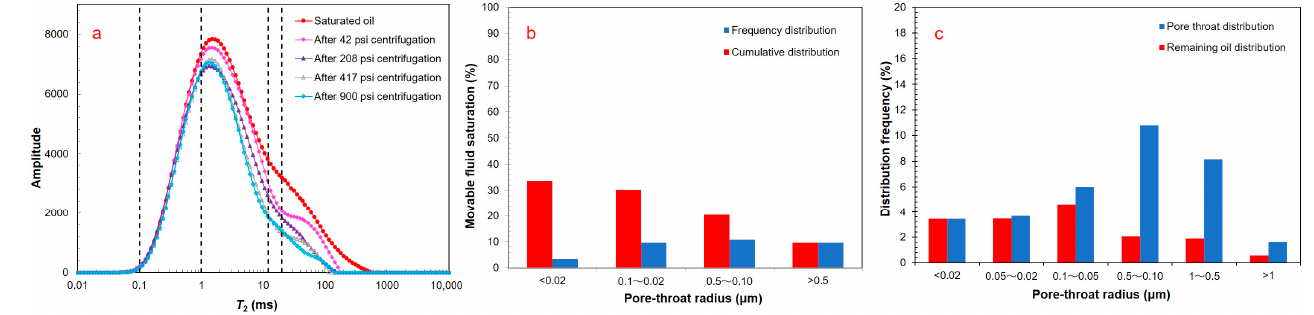
Figure 9. Centrifugal NMR results of core samples of type Ⅳ reservoir; ( a – c ) are the T 2 spectrum of centrifugal NMR, throat radius distribution frequency diagram and frequency distribution of residual oil in pore space of different scales of CD-9, respectively.